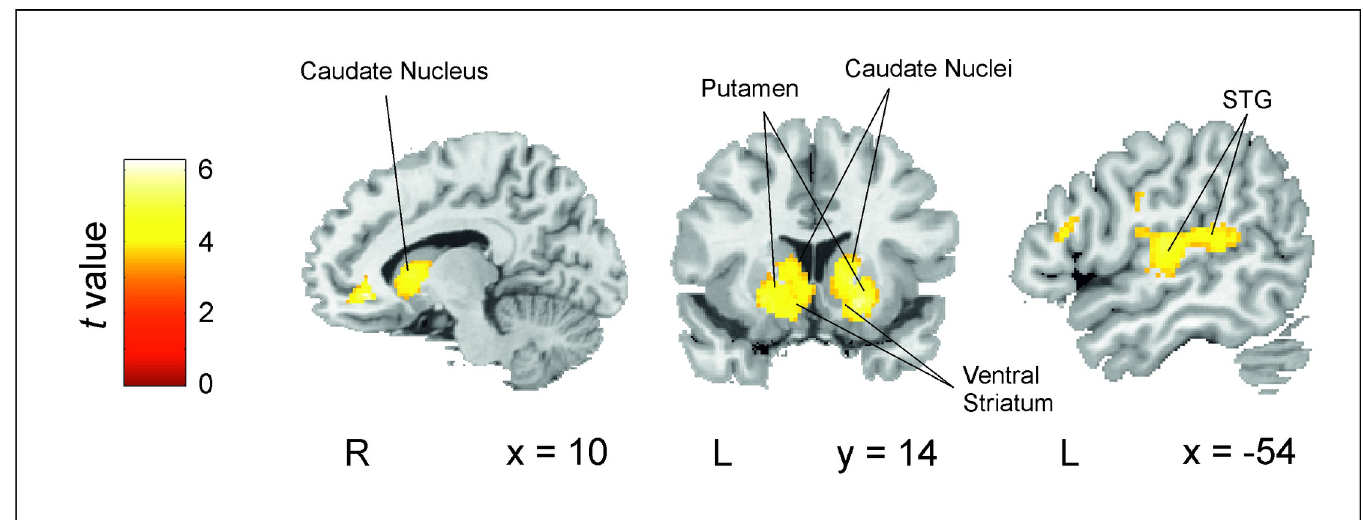
Fig 4. Brain regions related to changes in the predictive value of the initial word of each phrase in the NADs block vs. implicit baseline (i.e., NADs P (A)-modulated activity vs. implicit baseline). Activity in the basal ganglia (bilateral caudate nuclei, putamen, and ventral striatum) and in the left posterior STG was modulated by the trial-by-trial development of predictions ( P (A)) as estimated by the TD model (contrast: NADs P (A)—Baseline). Results are reported for clusters FWE-corrected at p < 0.001 at the cluster level (minimum cluster size = 20). Neurological convention is used with MNI coordinates shown at the bottom right of each slice. Data used to generate Fig 4 can be found in http://identifiers.org/neurovault.collection:10421. FWE, family-wise error; NAD, nonadjacent dependency; STG, superior temporal gyrus; TD, temporal